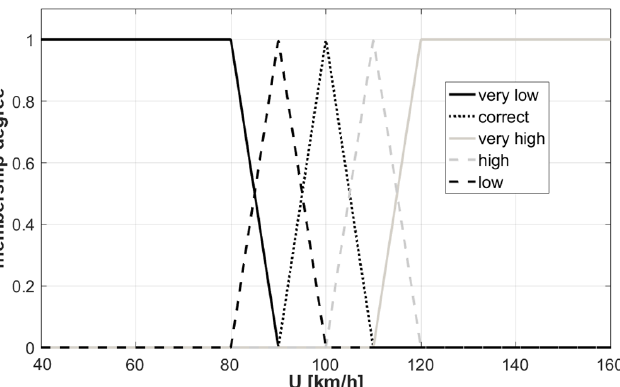
Figure 10. Membership degree of the input variable of height above the runway H associated with fuzzy sets: very low, low, high.